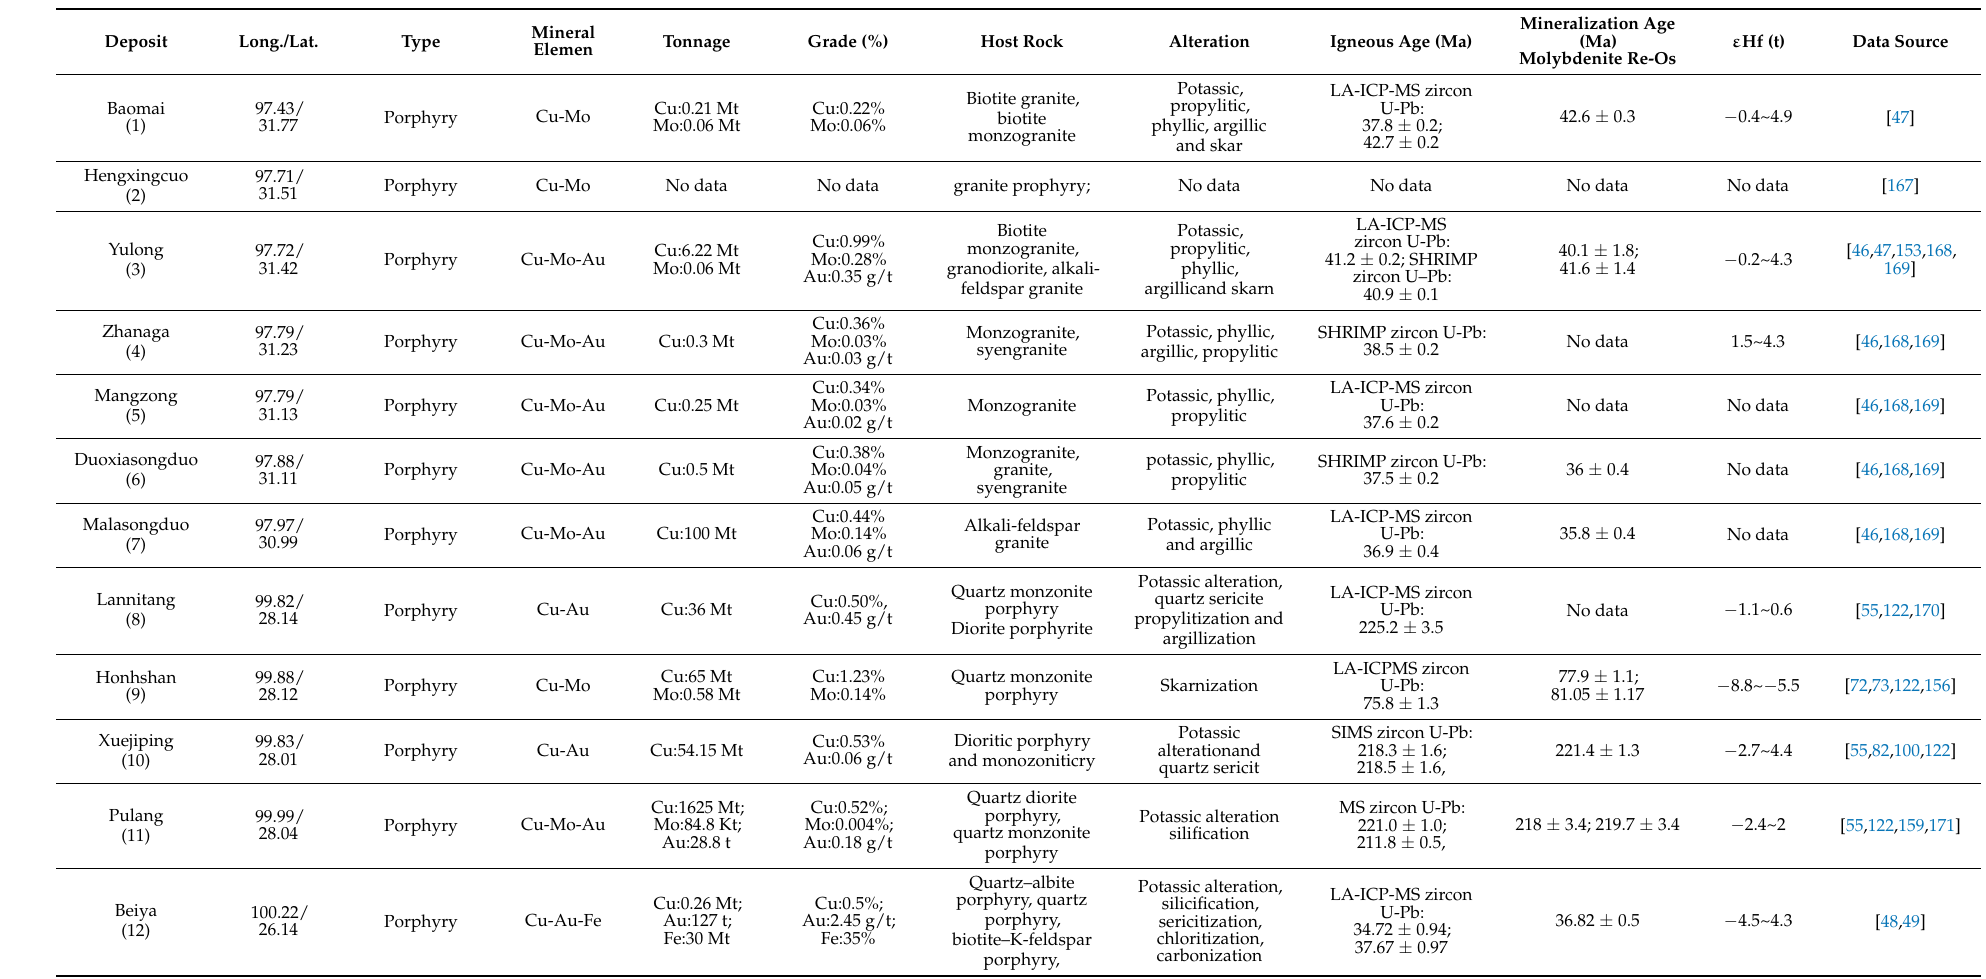
Table 1. A summary of the geological characteristics of major ore deposits in the Sanjiang Tethyan